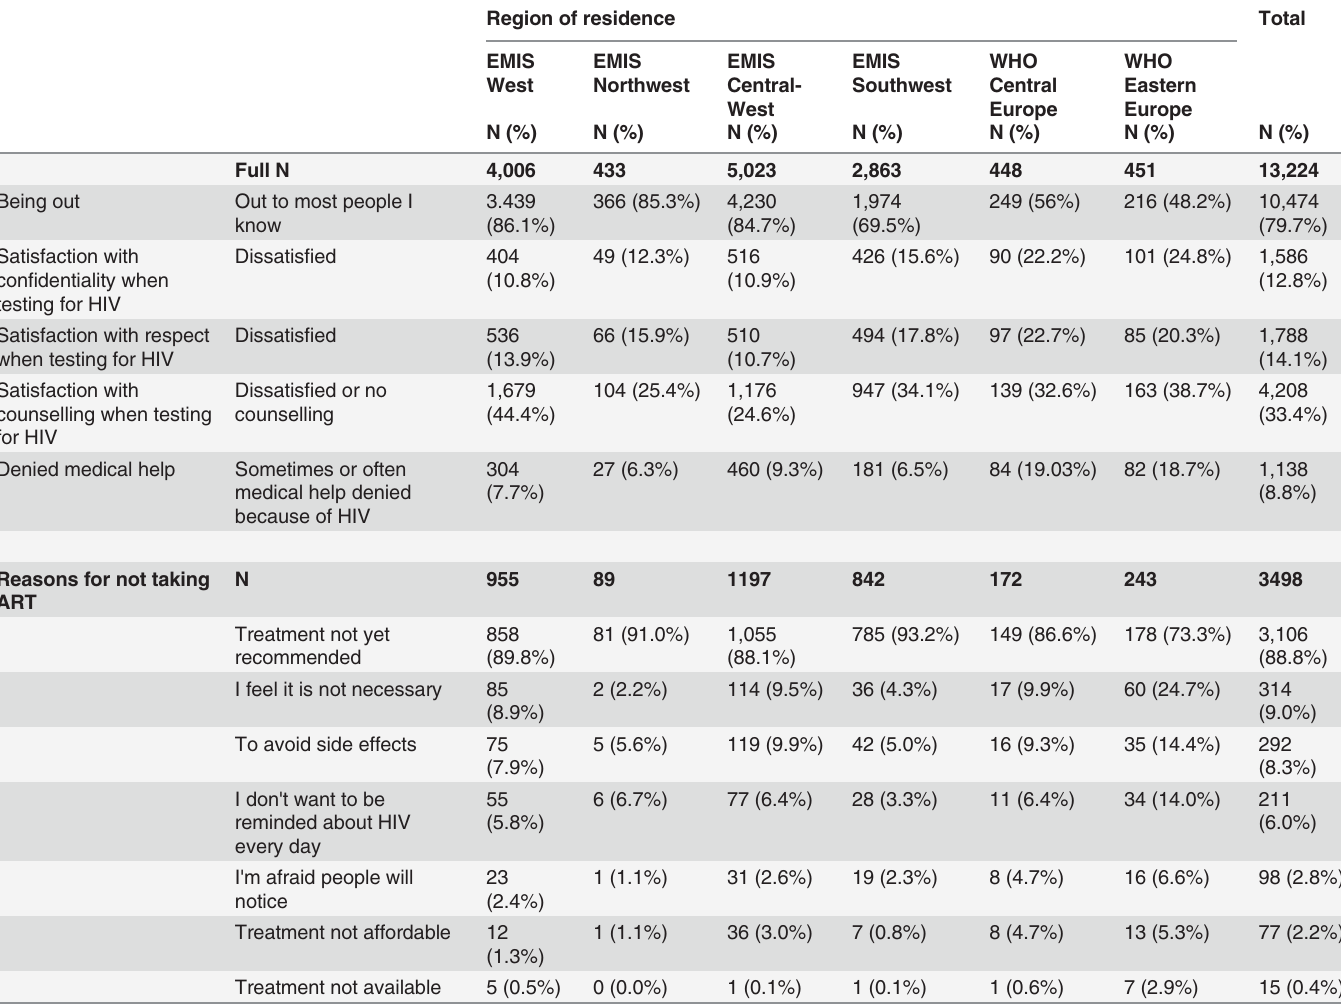
Table 5. Regional distribution of HIV-related health care experiences and reasons for not taking